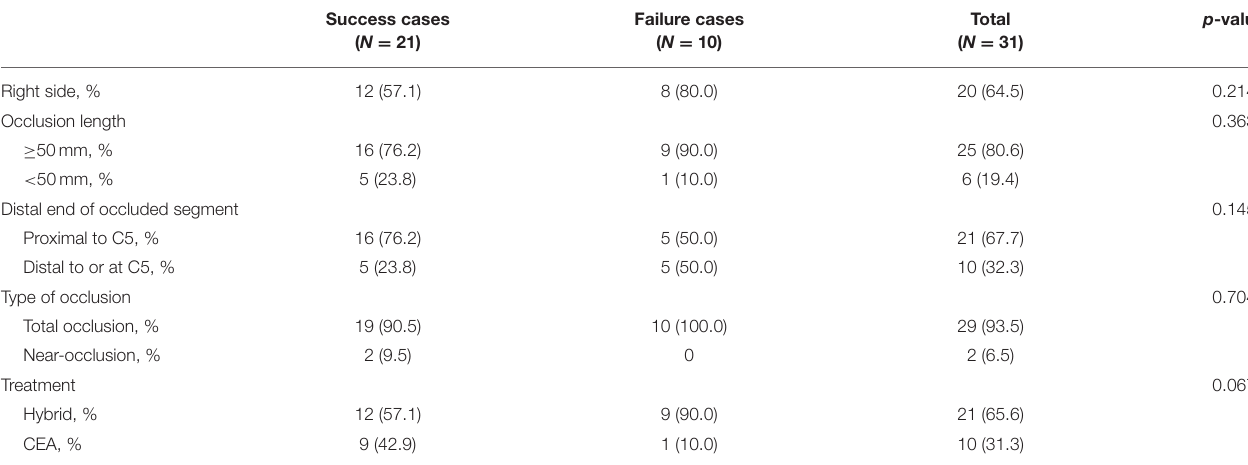
TABLE 2 | Clinical characteristics of lesions.